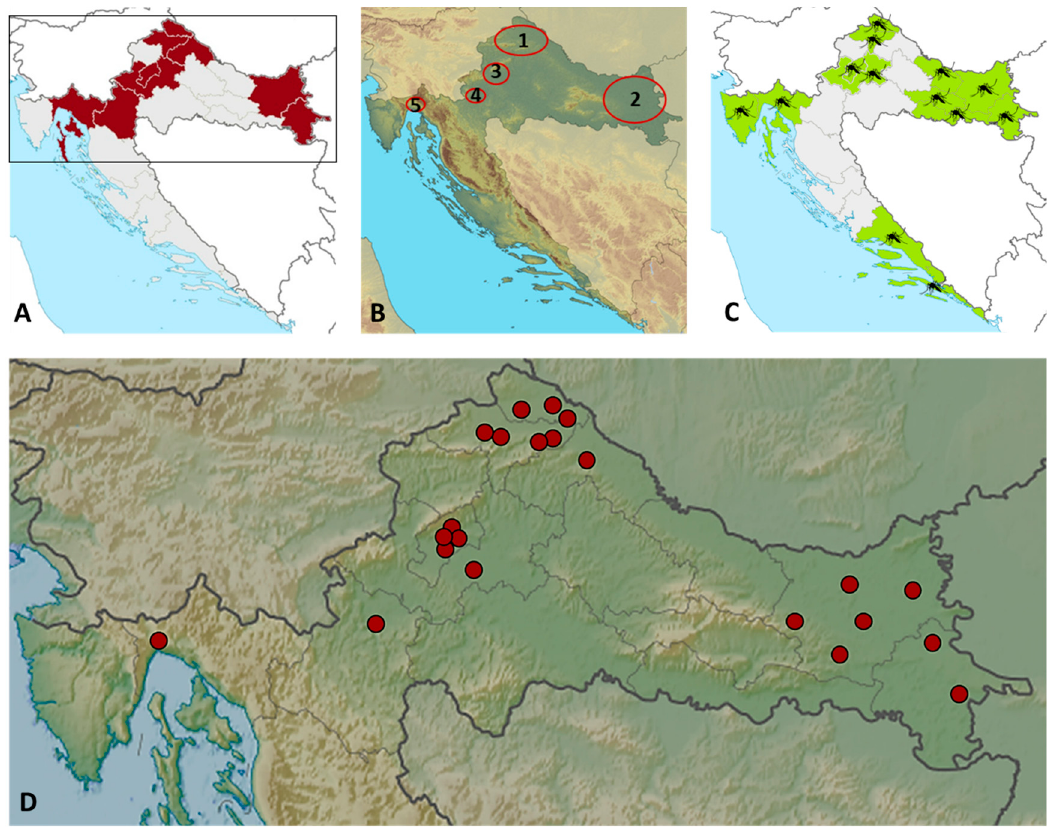
Figure 3. Geographic distribution of TAHV seropositive patients: counties with reported cases are shadowed in dark red ( A ); regions (1–5) with reported cases are circled ( B ); distribution of individual cases by counties ( D ); counties with numerous presence of Ae. vexans mosquitoes in Croatia are shadowed in light green ( C